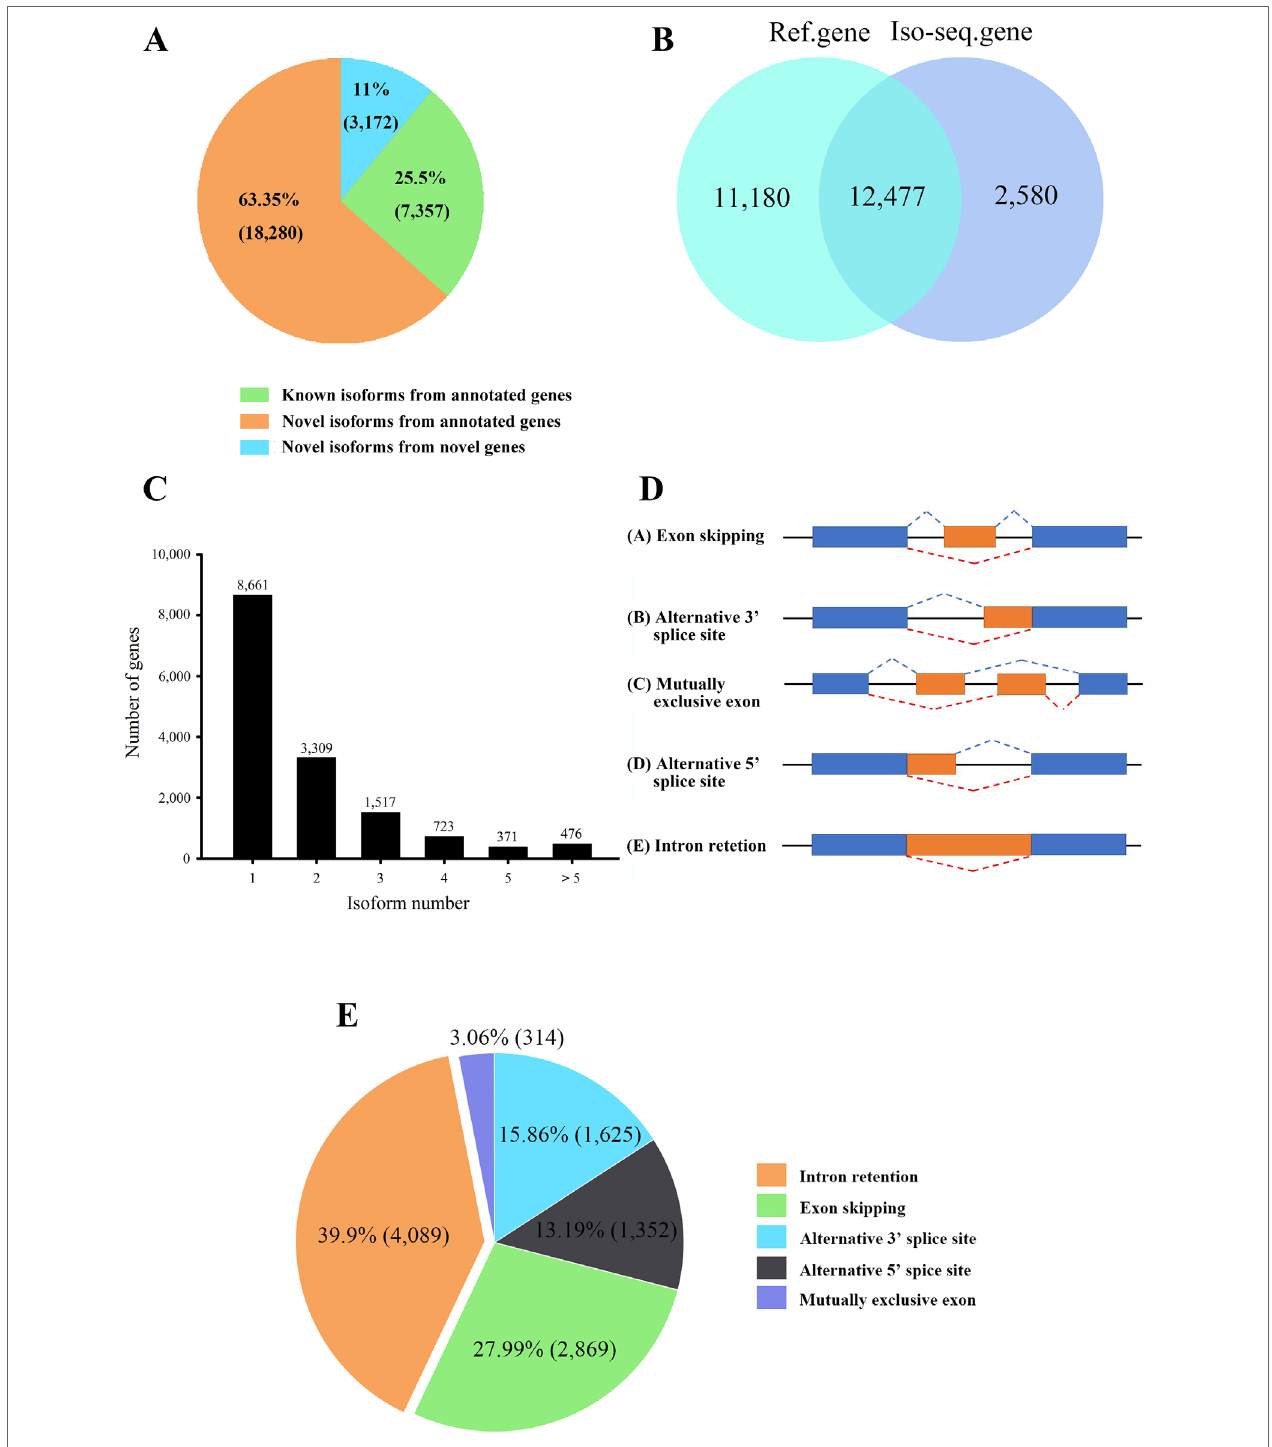
FIgURe 3 | Characteristics of transcripts and alternative splicing (AS) events of L. maculatus . (a) Numbers of three types of transcripts. (B) Venn diagram showing the common and unique genes from the L. maculatus genome and Iso-Seq. (C) Distribution of the number of isoforms per gene. (D) Schematic diagram of five types of AS events. (e) Pie chart showing the numbers of five AS events in Iso-Seq.